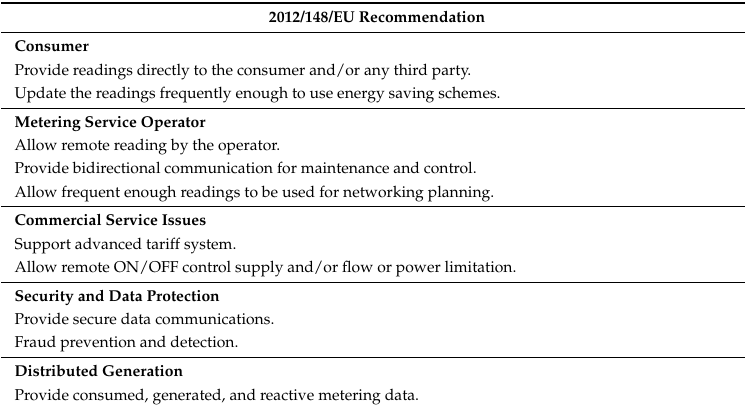
Table 1. Minimum requirements for electricity SM s according to 2012/148/EU